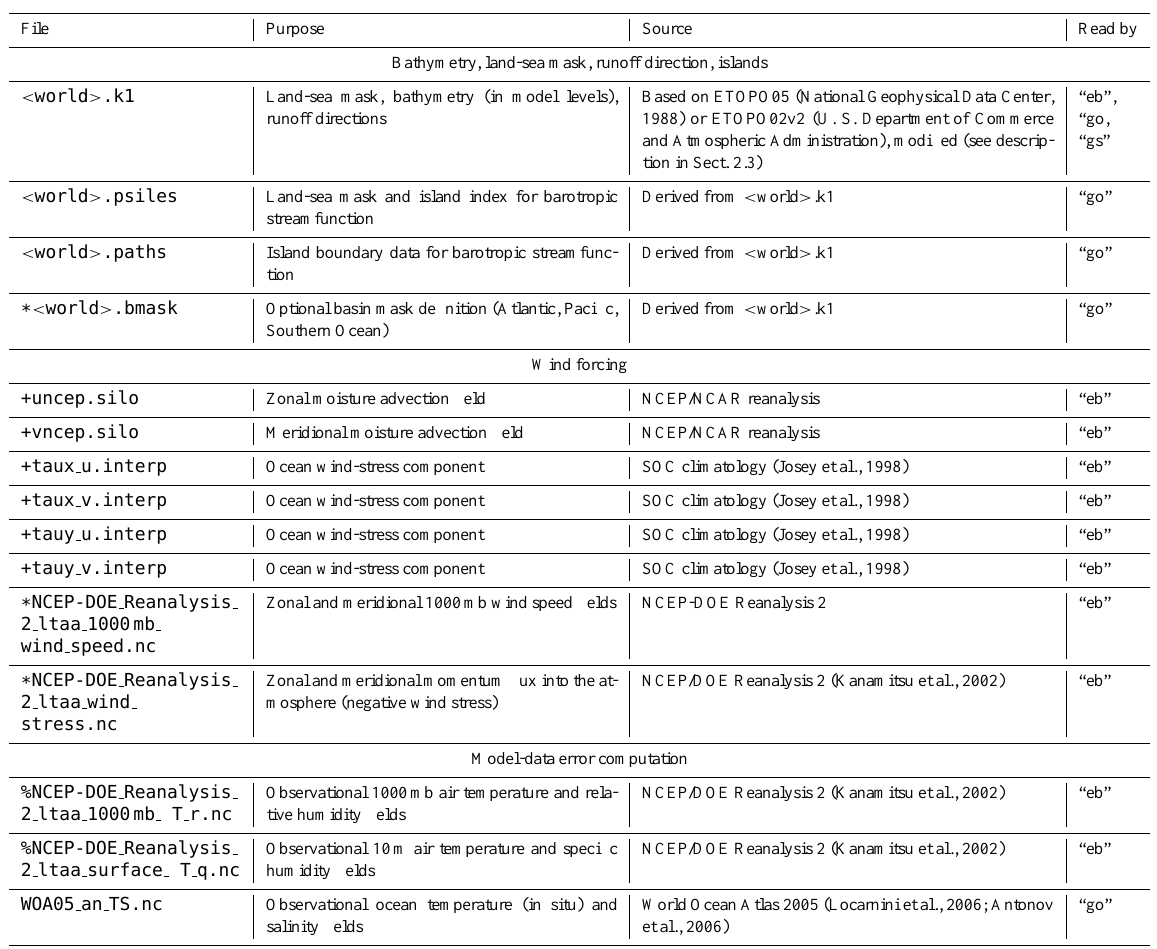
Table 1. Mesh-specific files required for the eb go gs experiments shown: < world > is “wv3jh2” for 3636s16l, “worjh2” for “biogem”, “w32jh2” for 7272s32l, “igcm16” for 6432i16l, and “3660l2” for 3660l16l; filenames with the prefix “+” are read in by all configurations but are only actively used when the run-time interpolation of wind forcing fields is not enabled (herein only by configuration “biogem”); the prefix “*” denotes files not required for “biogem”; the prefix “%” denotes alternative fields used for the error